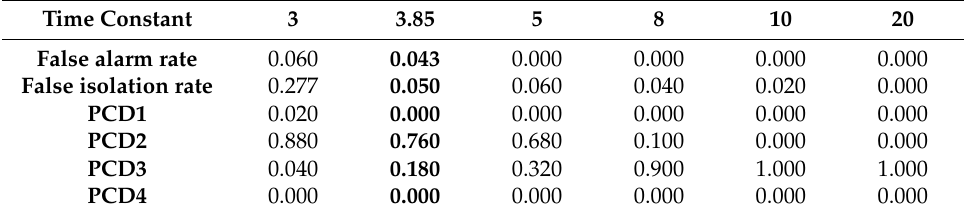
Table 3. The relationship between time constant and the effect on detecting faults (step fault 5 ◦ /h ).